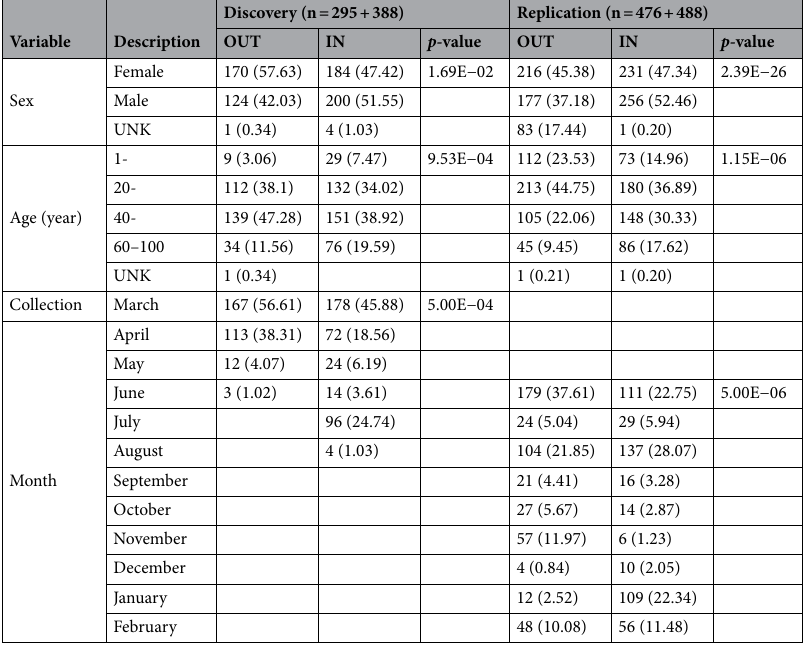
Table 1. Descriptive statistics of 683 and 964 participating patients in, respectively, the discovery and replication case–control studies.